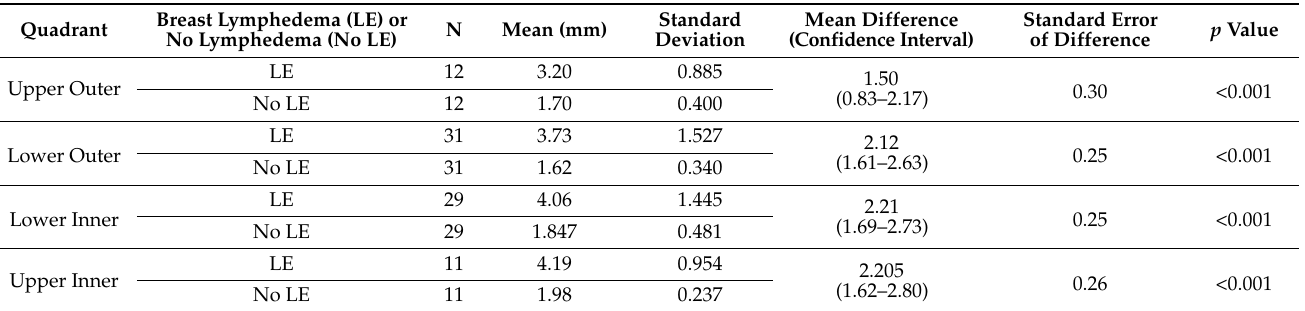
Table 5. Paired t -test comparing skin thickness measurement by ultrasound scanning of the individual breast quadrants.